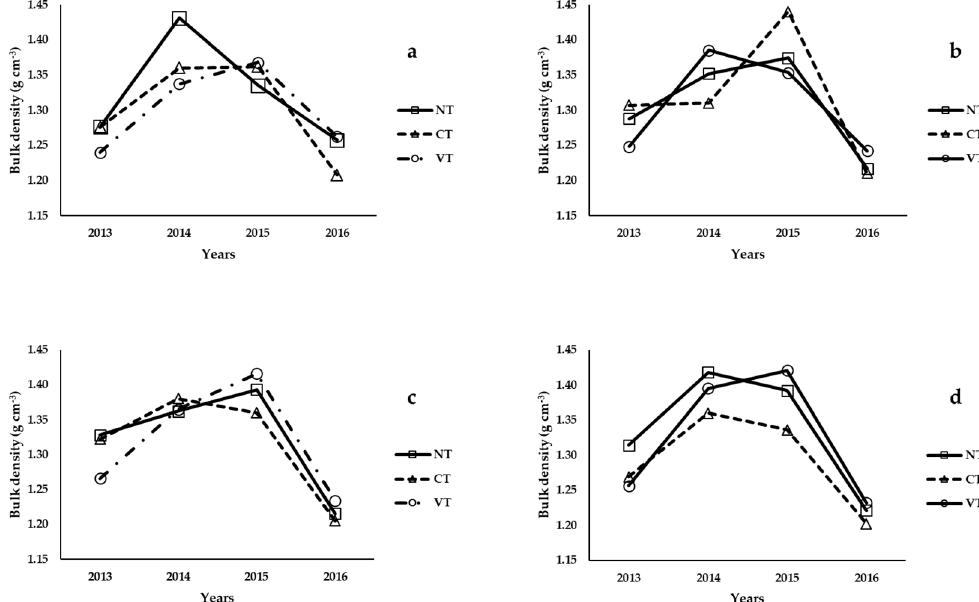
Figure 1. Bulk density (Bd) in the soil profile 0–5 cm ( a ), 5–10 cm ( b ), 10–15 cm ( c ) and 15–20 cm ( d ) for each year, with each tillage system. NT: No Tillage, VT: Vertical Tillage, CT: Conventional Tillage.